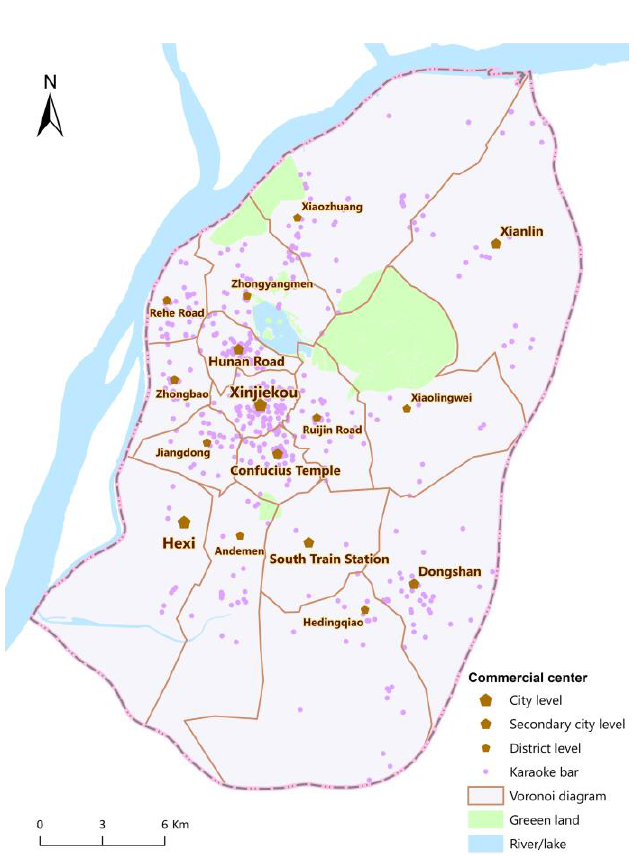
Figure 11. Network Voronoi diagram of commercial centers in Nanjing.